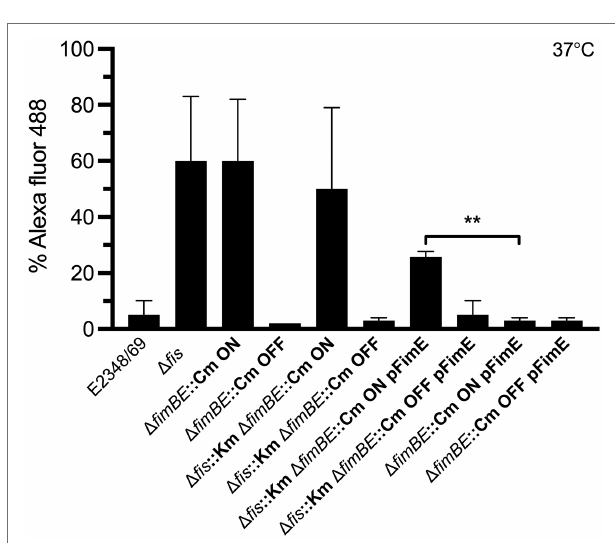
FIGURE 6 | FimE recombinase requires Fis to efficiently switch the fimS to the OFF state. T1P expression analysis using double and triple mutants in fimB , fimE , and fis with the fimS switch locked in either ON or OFF orientation and complemented with pFimE to evaluate T1P production. T1P was detected by flow cytometry using specific rabbit antibodies anti- T1P and goat anti-rabbit IgG Alexa Fluor conjugate. The Δ fis , Δ fimBE ON, and Δ fis Δ fimBE ON strains with the fimS locked in the ON orientation produce high levels of T1P pili. Although the E2348/69 Δ fis strain has a mix of the fimS orientations. No T1P expression was detected in the Δ fimBE ::Cm and Δ fis ::Km Δ fimBE ::Cm strains with the fimS locked in the OFF orientation. Interestingly, a 20-fold expression of T1P was displayed in the Δ fis ::Km Δ fimBE ::Cm ON strain ( fimS locked in the ON orientation) complemented with pFimE plasmid as compared to the Δ fimBE ::Cm ON pFimE strain ( fimS locked in the ON orientation), which was able to switch the fimS element to the OFF state completely. These data are the mean of at least three experiments performed in triplicate on different days. ** p <